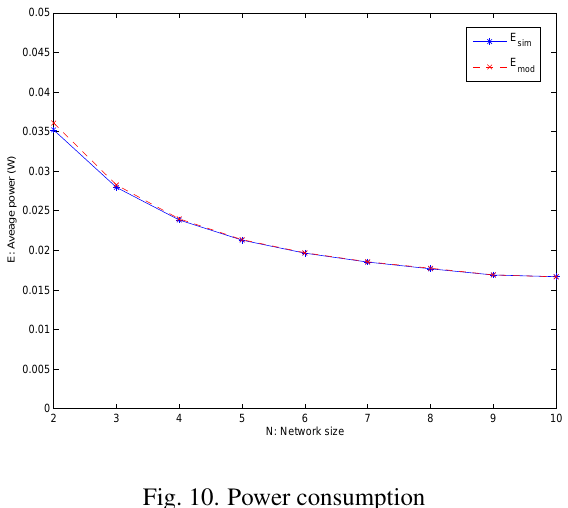
Fig. 10. Power consumption